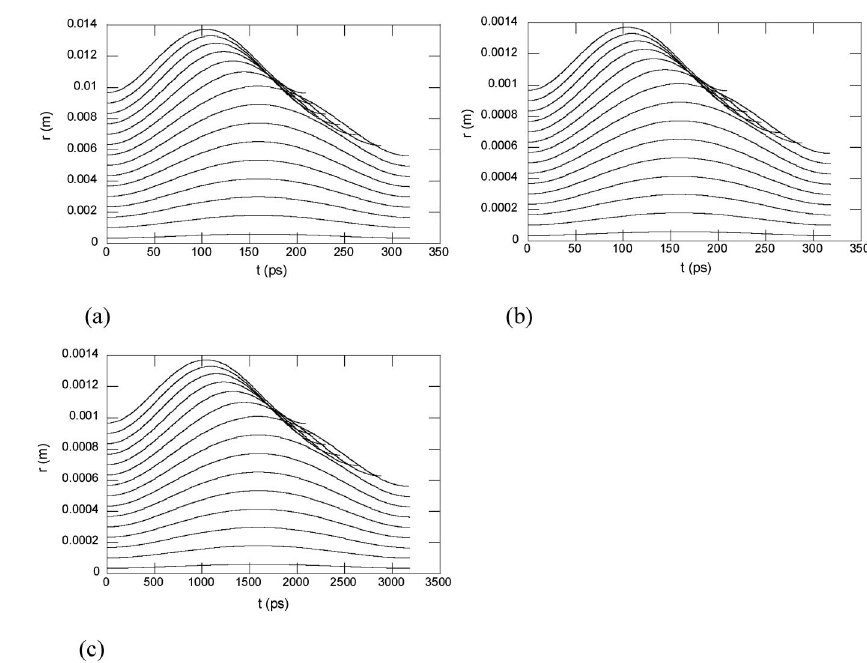
FIG. 1. One cyclotron orbit of electrons originated at 15 evenly spaced different initial locations within the primary electron beam for the parameters of (a) beam current 2 kA, focusing field 0.2 T, beam radius 1 cm, (b) beam current 20 A, focusing field 0.2 T, beam radius 1 mm, and (c) beam current 0.2 A, focusing field 0.02 T, beam radius 1 mm. On average, 48% of the current is outside the